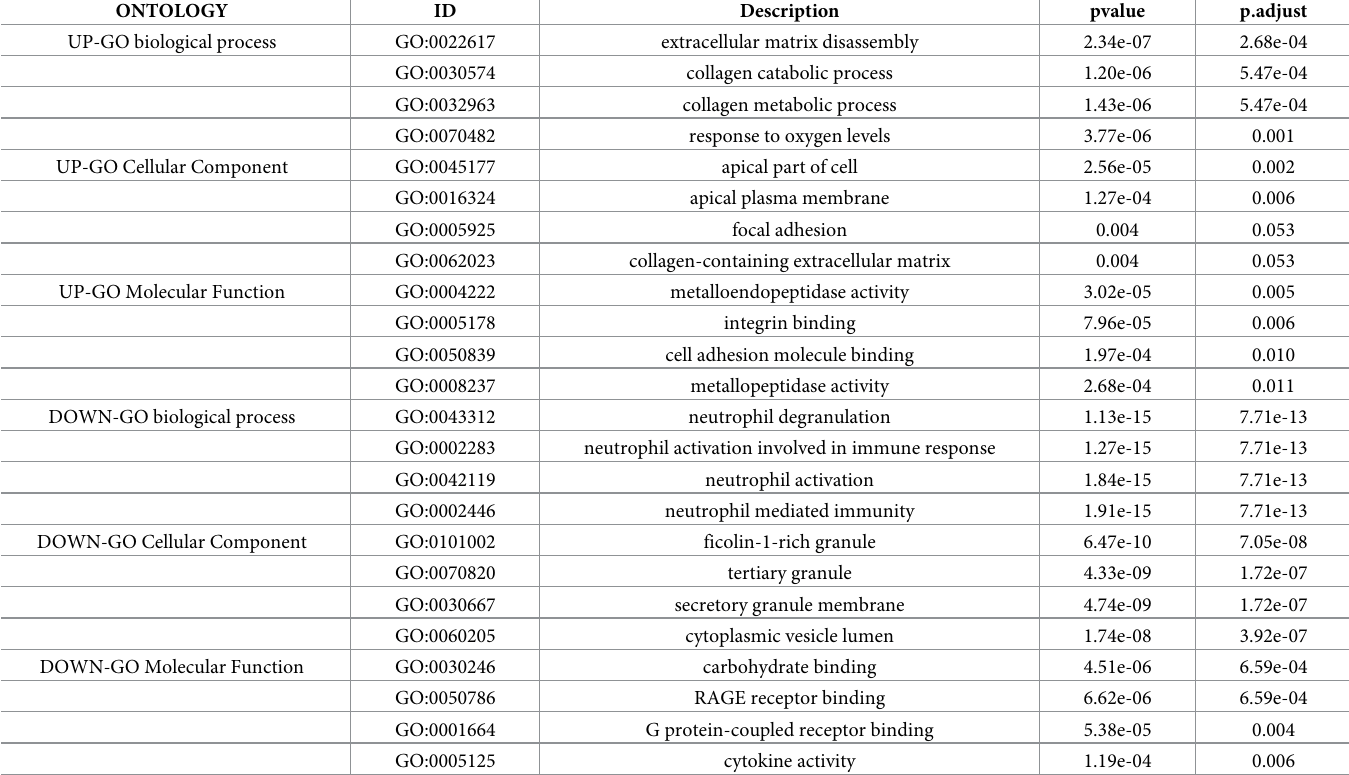
Table 1. GO analysis of common up-regulated DEGs and common down-regulated DEGs among COVID-19 and HCC. ONTOLOGY